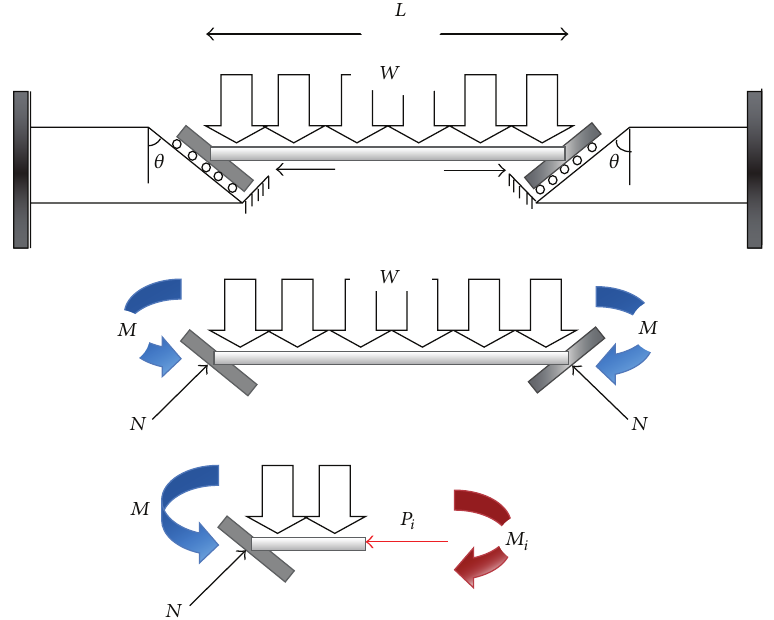
Figure 5: Simplification model of beam movement with slant end-plate connection due to increase in temperature and symmetric gravity load (frictionless